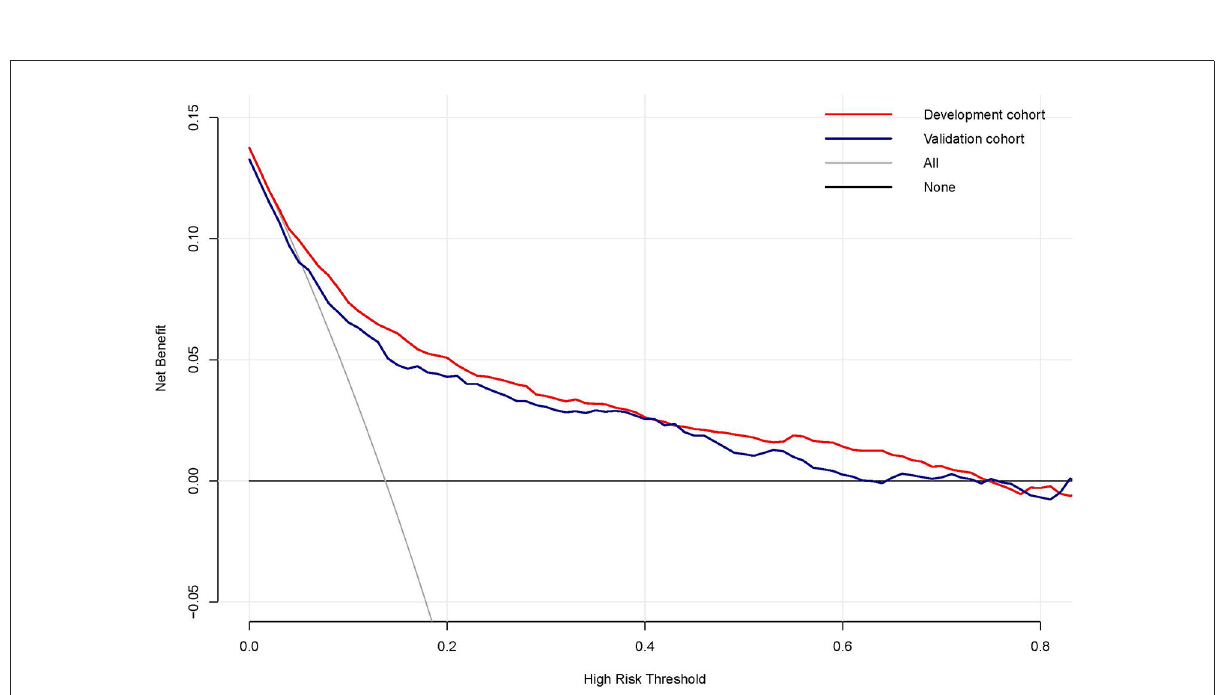
FIGURE5 The decision curve analysis of the risk prediction model of delayed extubation. The vertical axis measured the net benefit. The gray solid line represented the assumption that no patient has delayed extubation. The black solid line represented the assumption that all patients appeared delayed extubation. The red line and blue line represented the prediction model from the development and validation cohorts,